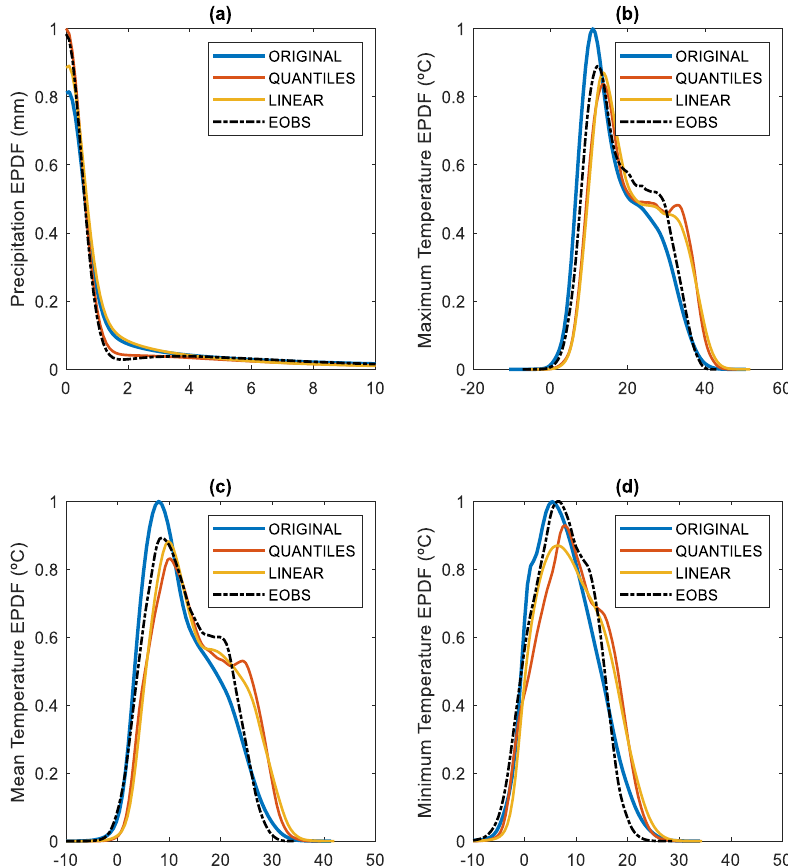
Figure 3. Empirical probability distribution functions (EPDF), with kernel-density estimation, for the future period (2051–2080) under the RCP8.5 scenario for the daily ( a ) total precipitation, ( b ) maximum temperature, ( c ) mean temperature, and ( d ) minimum temperature, for the original model simulation data (no bias correction; blue line) and the bias-corrected data using the quantile mapping (orange line) and linear (yellow line) methods. The corresponding EPDFs for E-OBS data are also depicted (historical data; dashed black